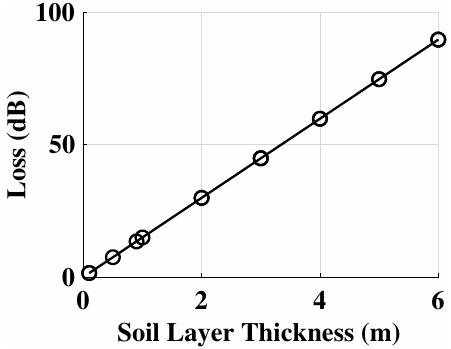
Figure 6. The propagation loss in the soil medium with change in layer thickness.